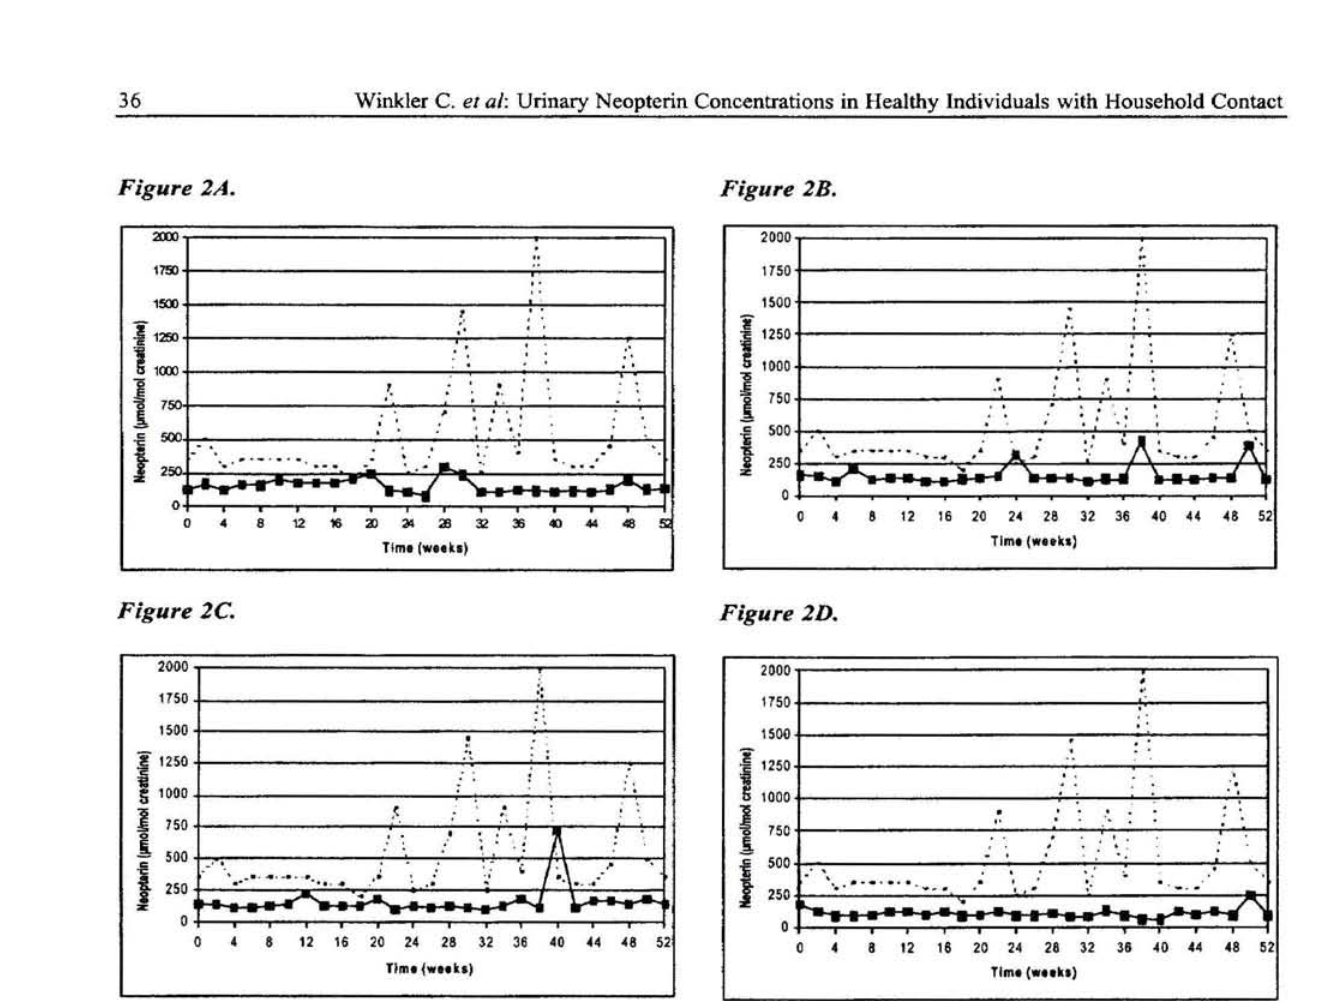
Figure 2A, B, C, D: Comparison of urinary neopterin concentrations (mmol neopterin/mol Creatinine) between the child (broken line) and her family members (through lines): mother (A),father (B), grandmother (C), grand- father (D). neopterin concentration were found in father vs.